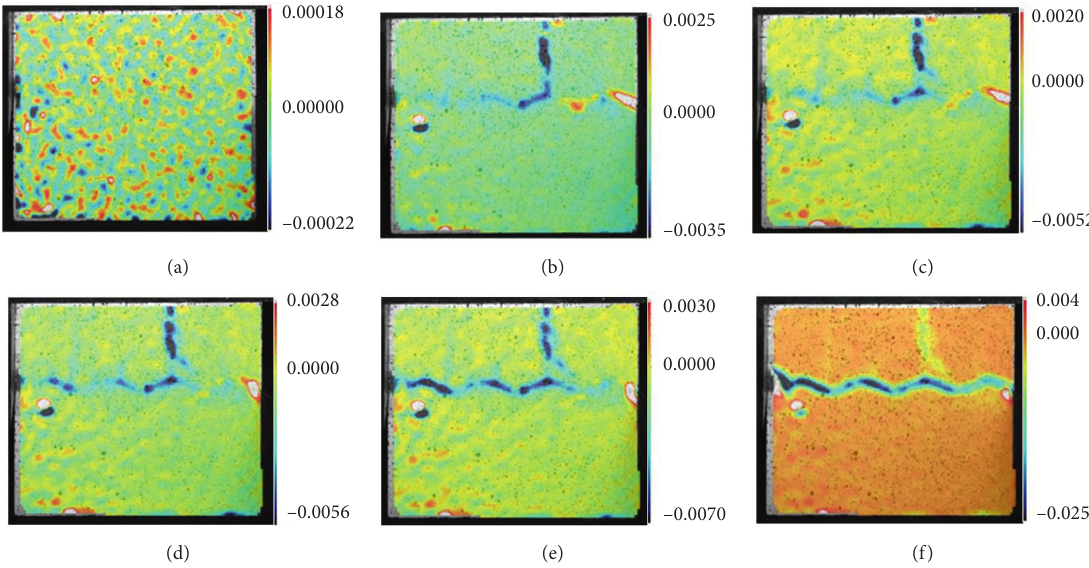
Figure 7: Shear strain evolution of jointed specimens (B-5). (a) Load level of 10%. (b) Load level of 30%. (c) Load level of 50%. (d) Load level of 70%. (e) Load level of 90%. (f) Load level of